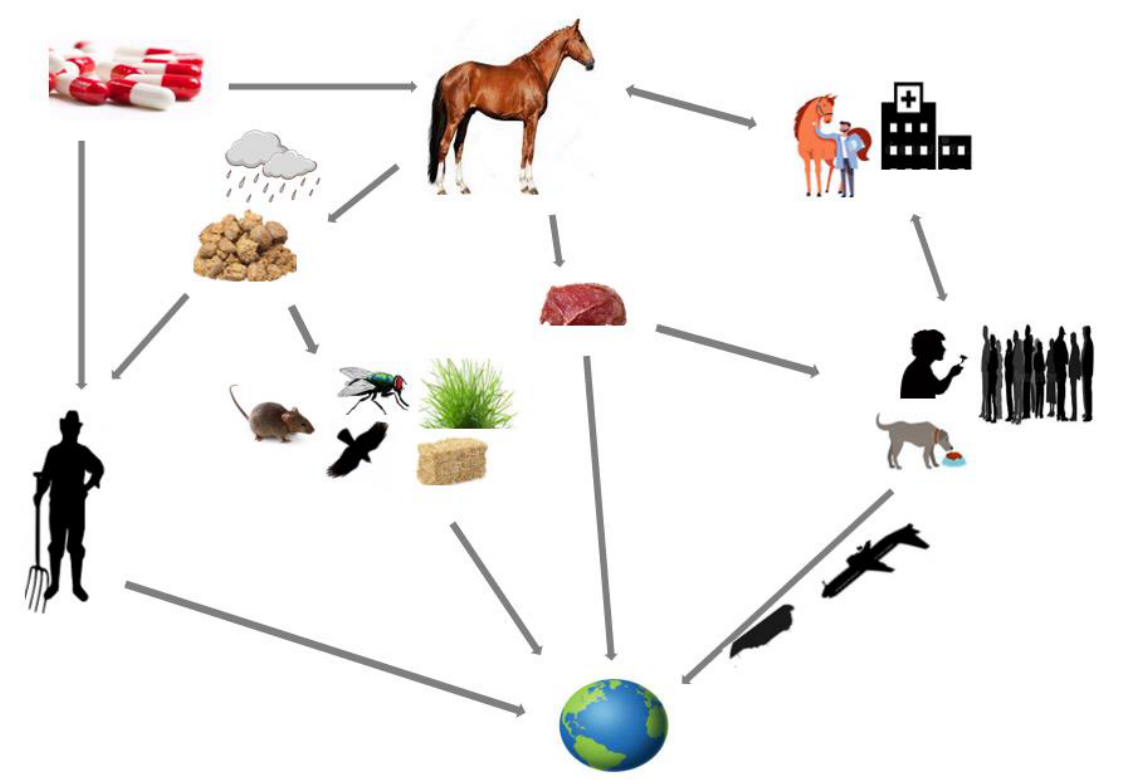
Figure 1. Possible sources of mcr -gene-bearing organisms in horses and their routes of transmission in the One Health triad.